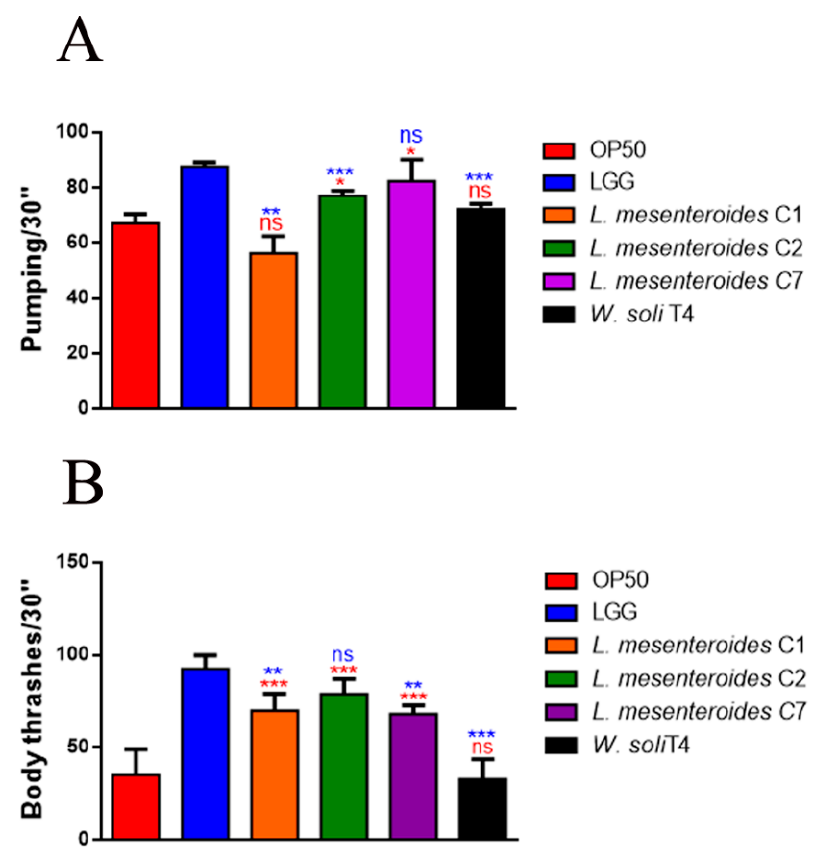
Figure 3. Impact of the different isolates on C. elegans aging markers. ( A ) Pumping rate of 10-day- old worms measured for 30 s. 10 worms were used for each condition. Worms fed OP50 or LGG were taken as controls. ( B ) Body bending of C. elegans -fed isolates as compared to LAB reference strain LGG or OP50, measured for 30 s. Bars represent the mean of three independent experiments. Statistical analysis was evaluated by one-way ANOVA with the Bonferroni post-test. Asterisks indicate significant differences (* p < 0.05, ** p < 0.01, *** p < 0.001) as compared to LGG (blue asterisks) or OP50 (red asterisks) controls, ns: not